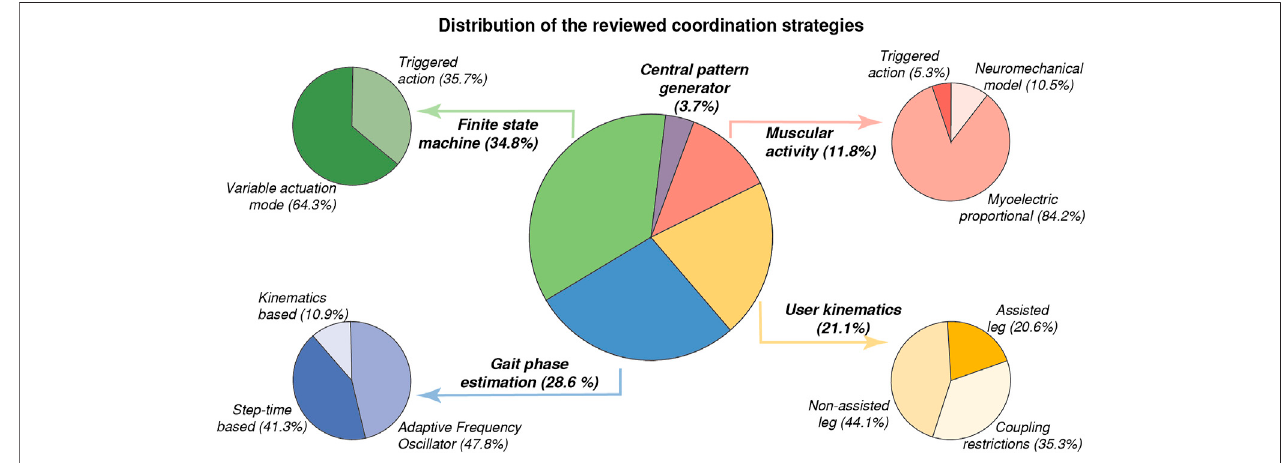
FIGURE 8 | Articles distribution according to the strategy proposed to coordinate the action of a partial robotic exoskeleton with the actual user gait.